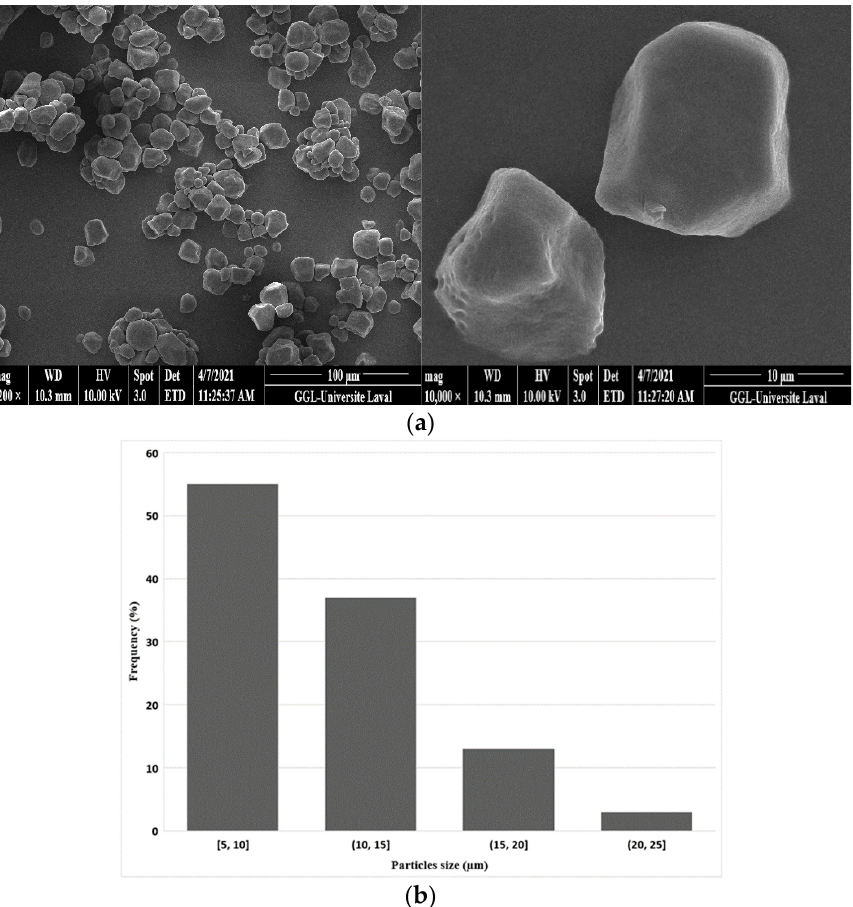
Figure 3. ( a ) Typical SEM images of the original corn starch particles and ( b ) their particle size